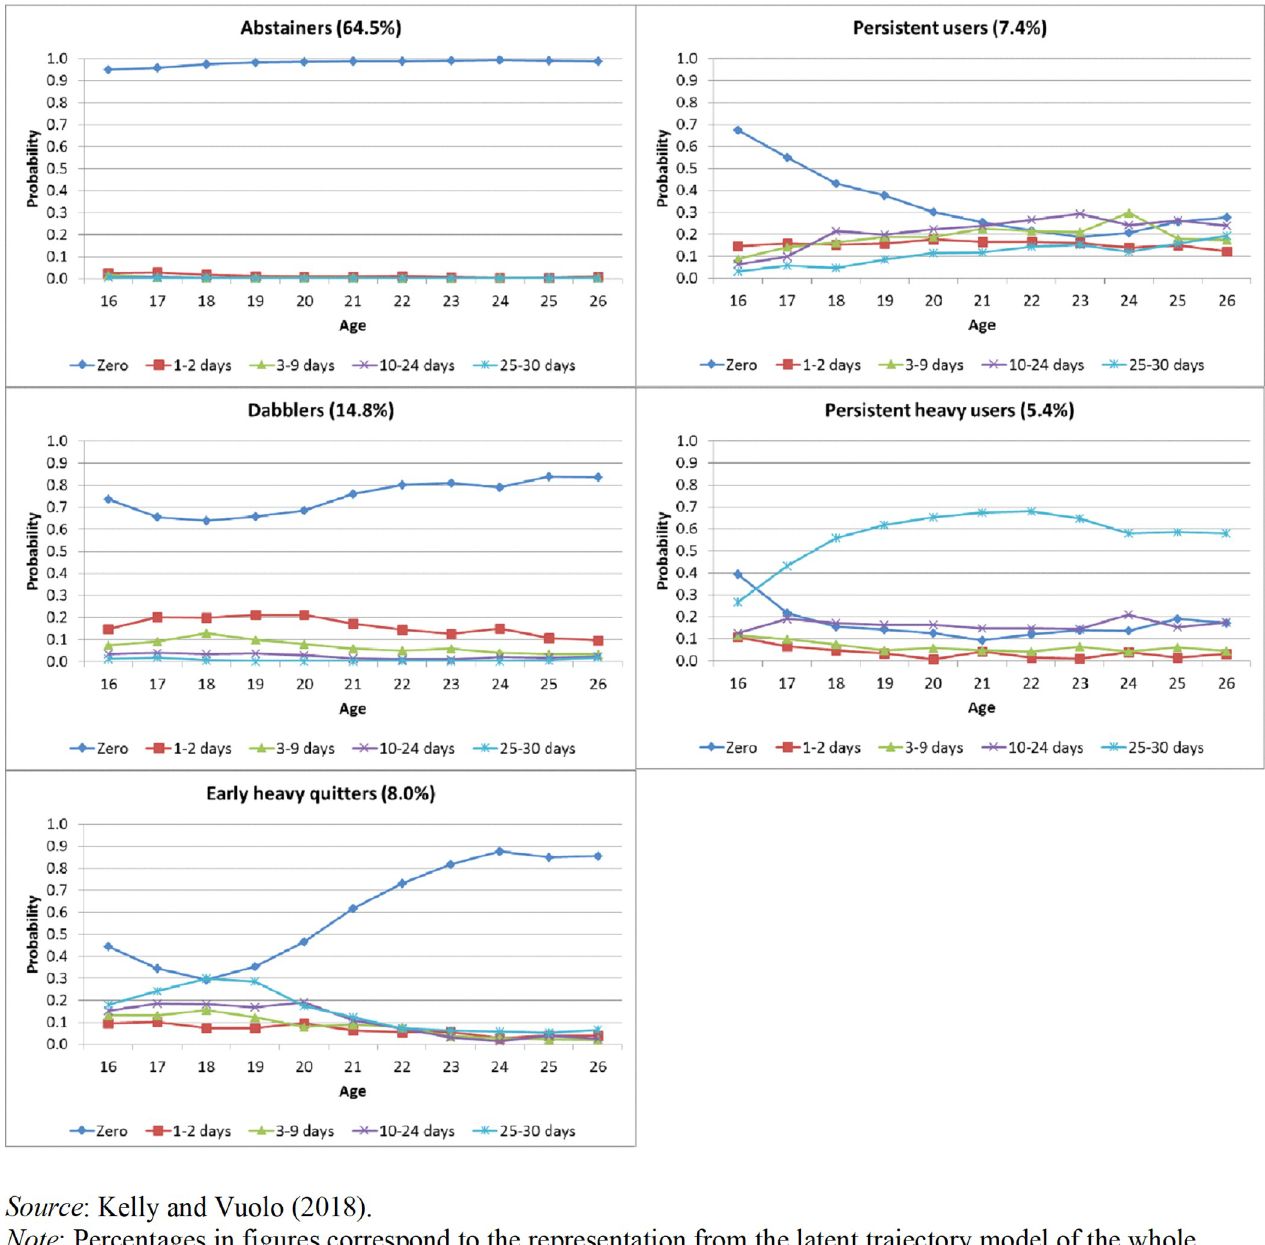
Fig 1. Latent trajectory analyses of marijuana use over time. Source : Kelly and Vuolo (2018).